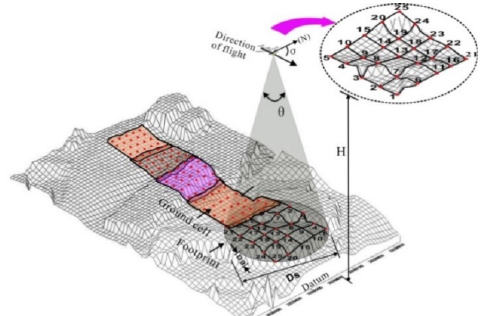
Figure 3: a 5×5 array (flash) LiDAR system for point cloud data collection (Courtesy of Zhou et al. (2015))